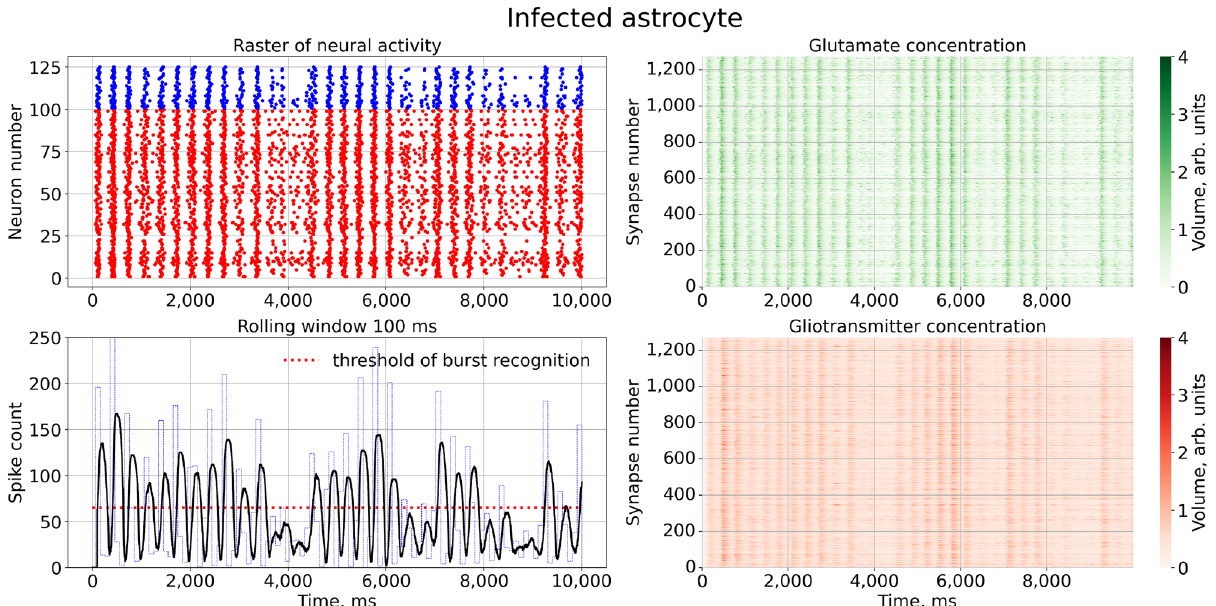
Figure 4. Raster chart of neural activity and dependences of gliotransmitter and neurotransmitter concentration from time with infected astrocyte feedbacks for γ virus = 0.10 .